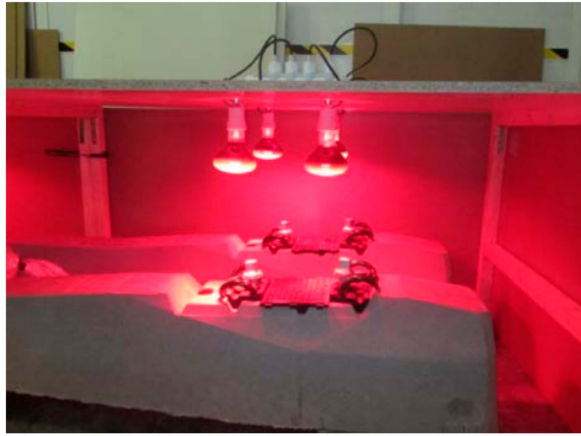
Figure 3. Sleepers heating process.